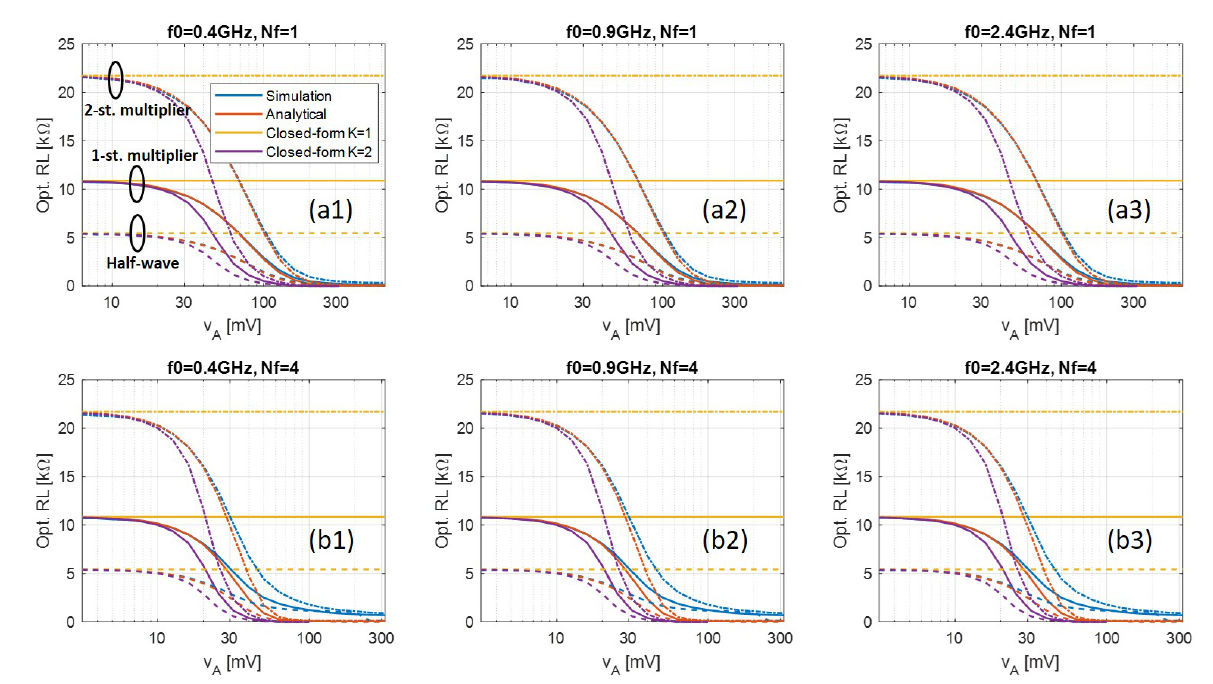
Figure 3. Optimal load calculated by transient simulation (blue), numerical solution of the analytical model (red), and closed-form solutions (yellow and purple), when ( a ) N f = 1, and ( b ) N f = 4 with ∆ f = 1 MHz, with half-wave, 1-, and 2-stage voltage-multipliers using Skyworks SMS7630. The results under different frequency bands ( a1 , b1 ) 400 MHz, ( a2 , b2 ) 900 MHz, and ( a3 , b3 ) 2.4 GHz are shown,